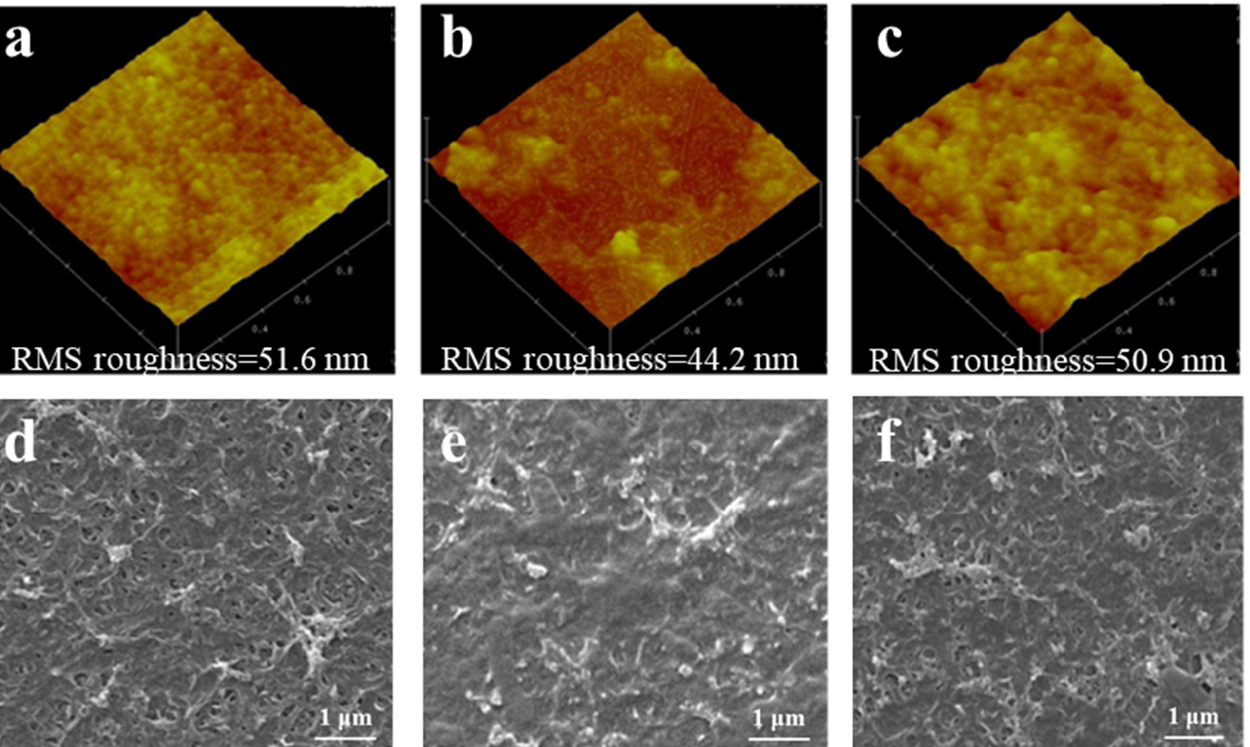
Figure 8. AFM images of ( a ) virgin, ( b ) fouled, and ( c ) cleaned MPCM2; SEM images of ( d ) virgin, ( e ) fouled, and ( f ) cleaned MPCM2.